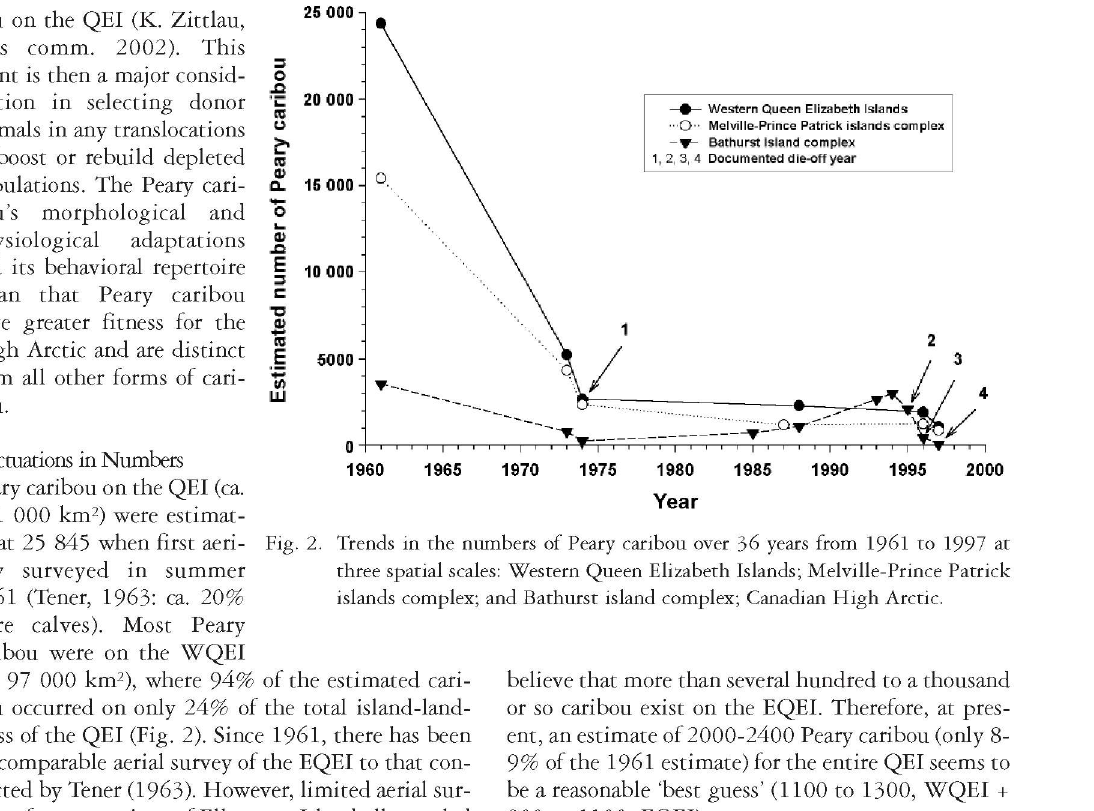
Fig. 2. Trends in the numbers of Peary caribou over 36 years from 1961 to 1997 at three spatial scales: Western Queen Elizabeth Islands; Melville-Prince Patrick islands complex; and Bathurst island complex; Canadian High